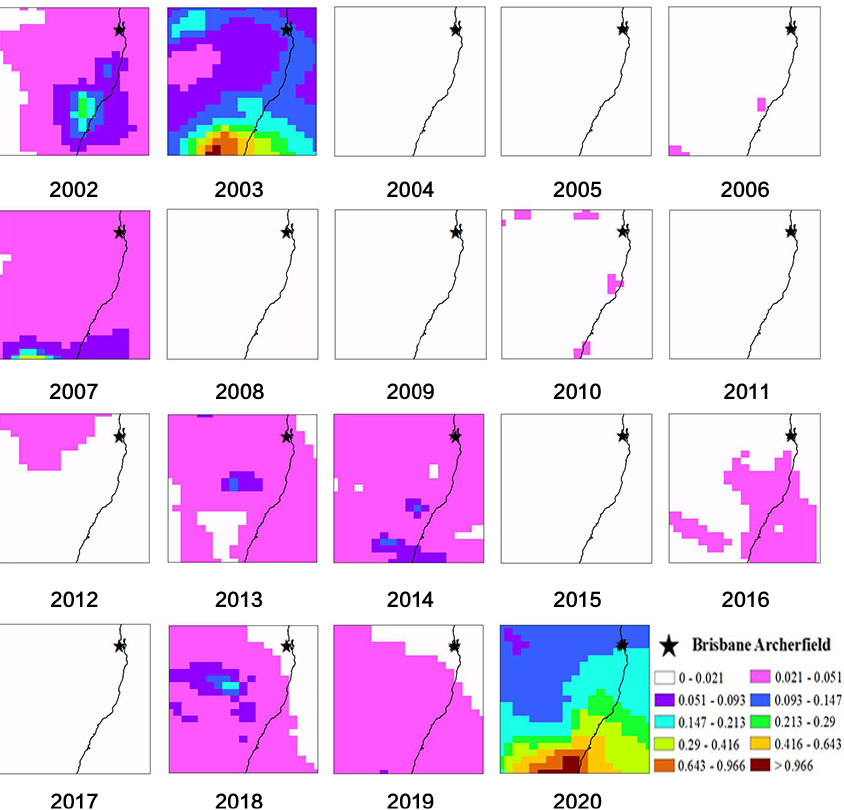
Figure 11. The spatial distribution of aerosol optical depth (AOD) of organic carbon (OC) in eastern Australia during January from 2002 to